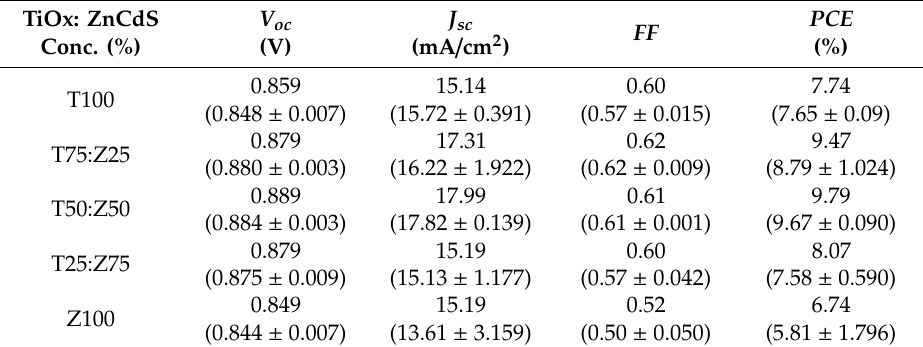
Table 2. Performances of perovskite solar cells fabricated from different T:Z ETL.